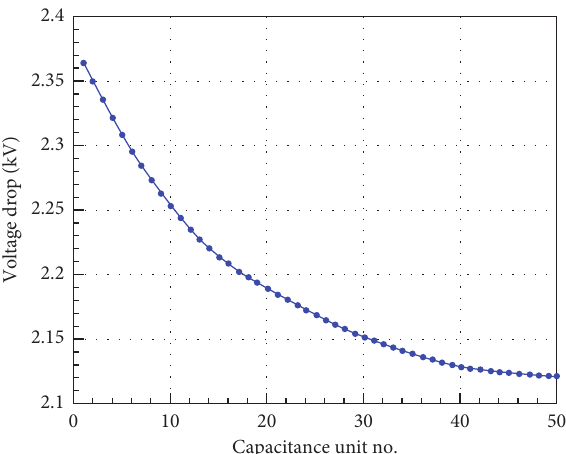
Figure 7: Voltage drop on each capacitance unit of the test CVD.